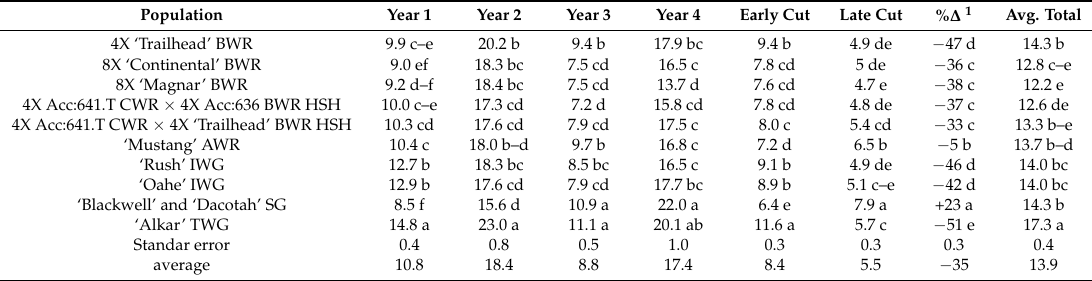
Table 4. Dry matter yield (Mg · ha − 1 ) for basin wildrye (BWR), creeping wildrye (CWR) × BWR half-sib hybrids (HSH), Altai wildrye (AWR), intermediate wheatgrass (IWG), switchgrass (SG), and tall wheatgrass (TWG) in a two-harvest, irrigated production experiment at the Western Colorado Agriculture Experiment Station. Significant differences among groups of entry means are indicated by lettered ranks, within table columns, based on least significant